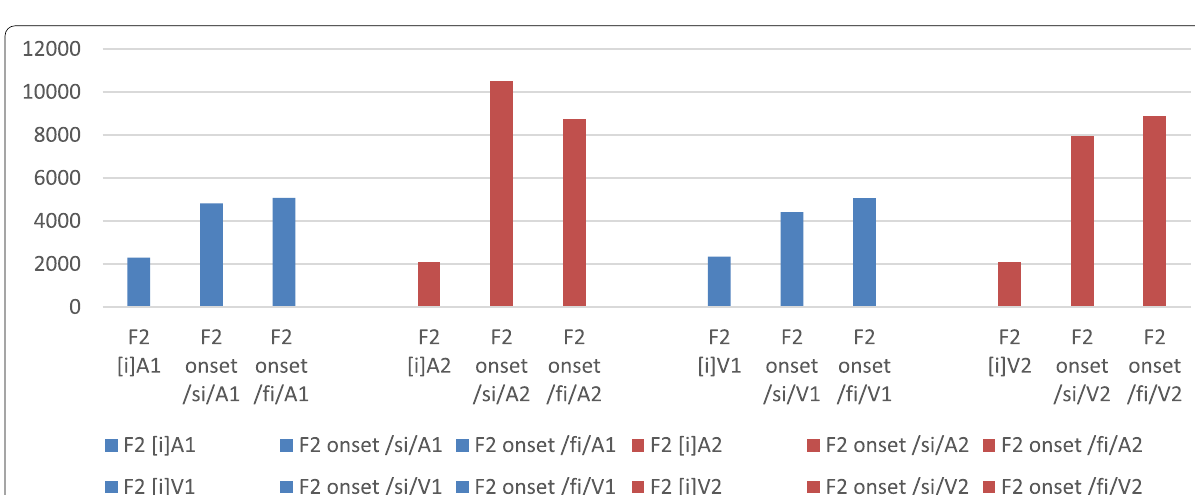
Fig. 3 Mean F2 in [i] and mean F2 onset in /si/ and /fi/ in audio and audiovisual presentations, 1 month and 6 months after NLFC fitting. A, audio presentation. V, audiovisual presentation. 1, first evaluation 1 month after NLFC fitting (blue). 2, second evaluation 6 months after NLFC fitting